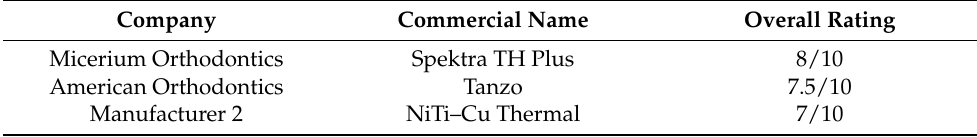
Table 15. The overall rating of Thermal